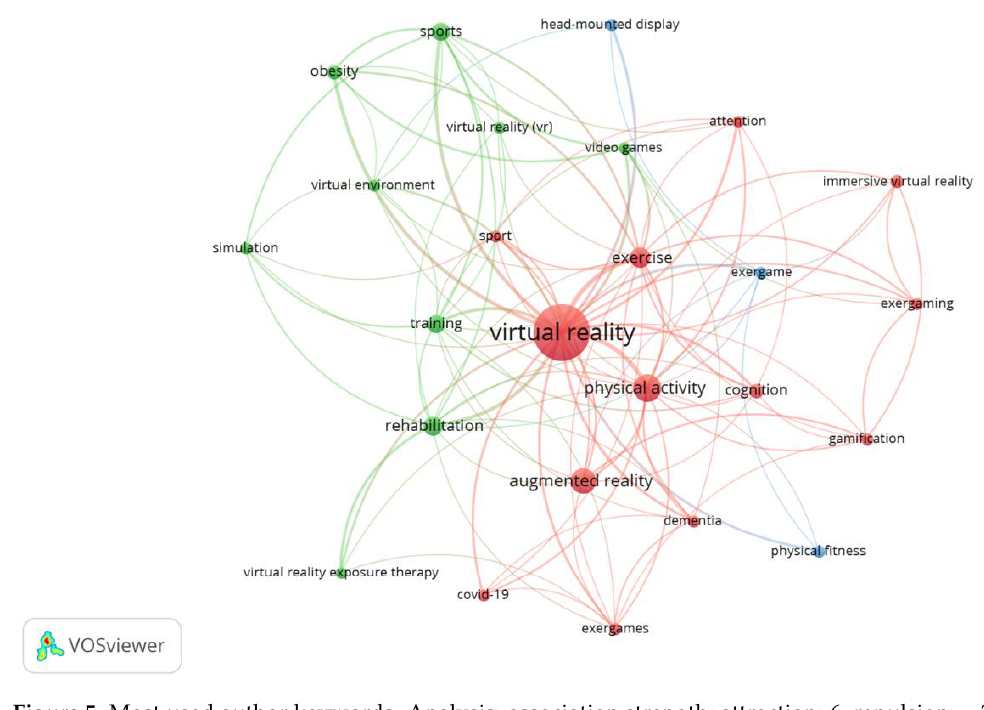
Figure 5. Most used author keywords. Analysis: association strength; attraction: 6, repulsion: − 2, clustering: resolution (0.5) and minimum cluster size: -2, node size: occurrences, colour: cluster.